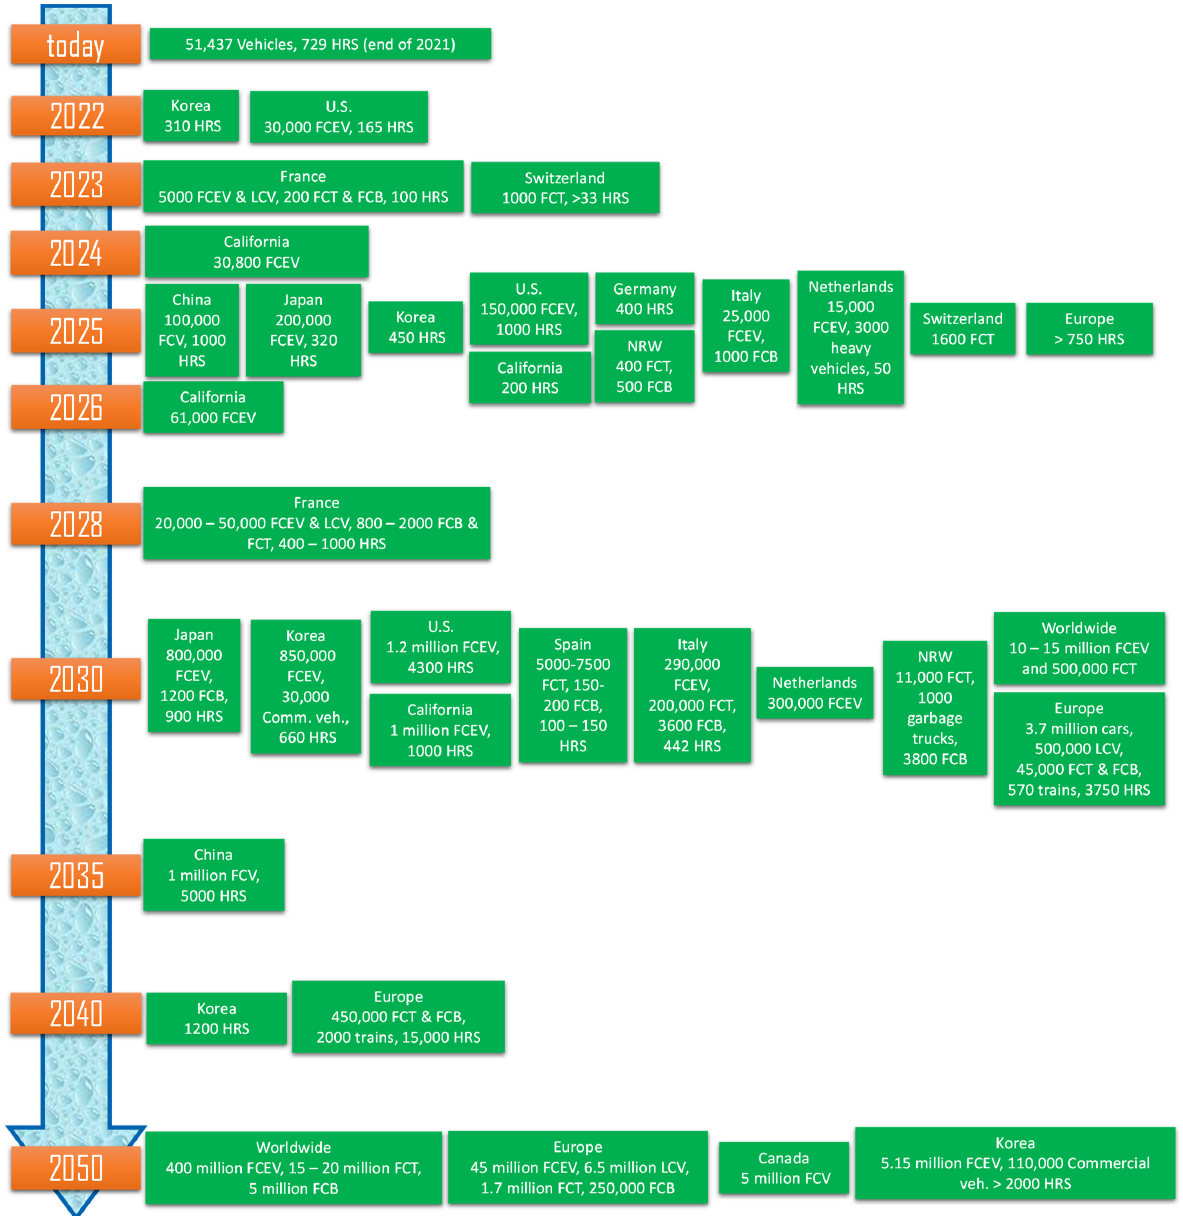
Figure 9. Visual summary of the communicated targets, visions, and projections discussed. The infor- mation sources and types of target (roadmap, national target or vision) are explained in Section